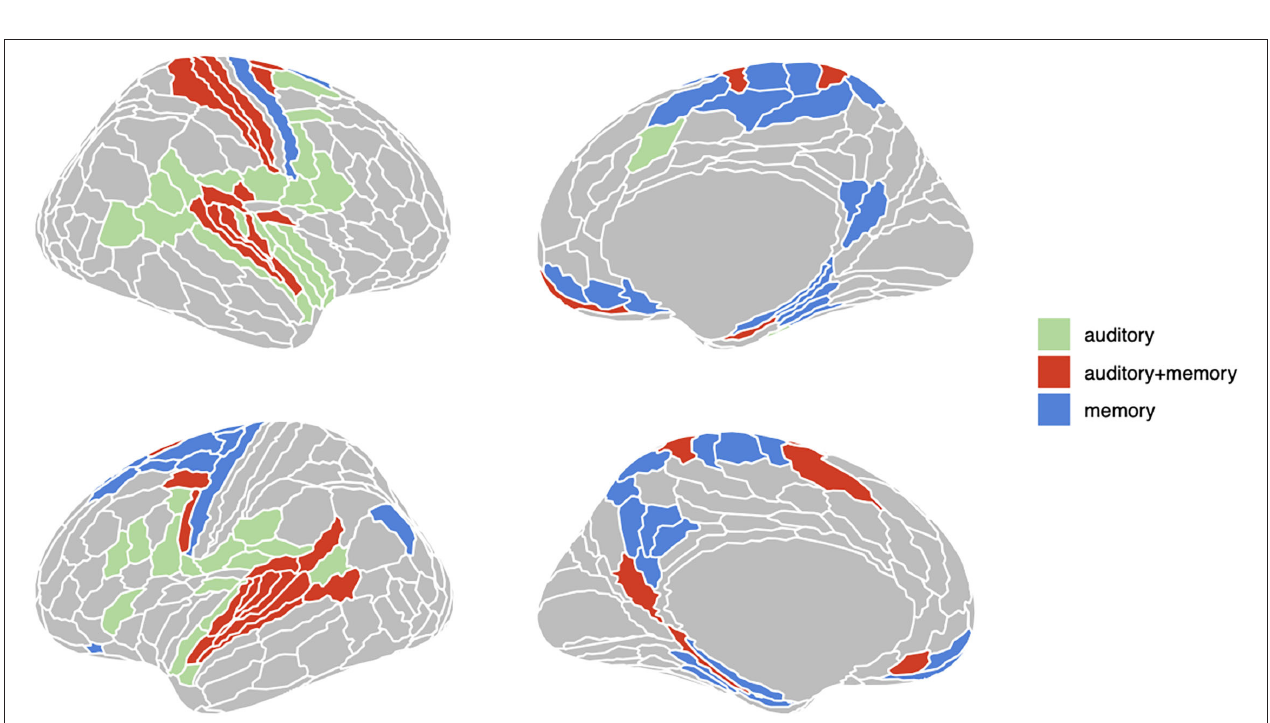
FIGURE 1 | Area Spt and PSL. Left: Lateral view of peak coordinates ( − 51, − 43, 20) of Area Spt as reported in Buchsbaum et al. (24) meta-analysis of auditory-verbal working memory studies. Right: lateral view of PSL (perisylvian language area), a “parcel” fined by a multimodal clustering approach of Glasser et al. ( 49). The peak coordinates of Spt are contained within the boundaries of PSL [PSL has a right-hemisphere homolog whereas right-sided Spt activity sometimes evident in single subjects ( 25), but often fails to reach significance in group level analyses].